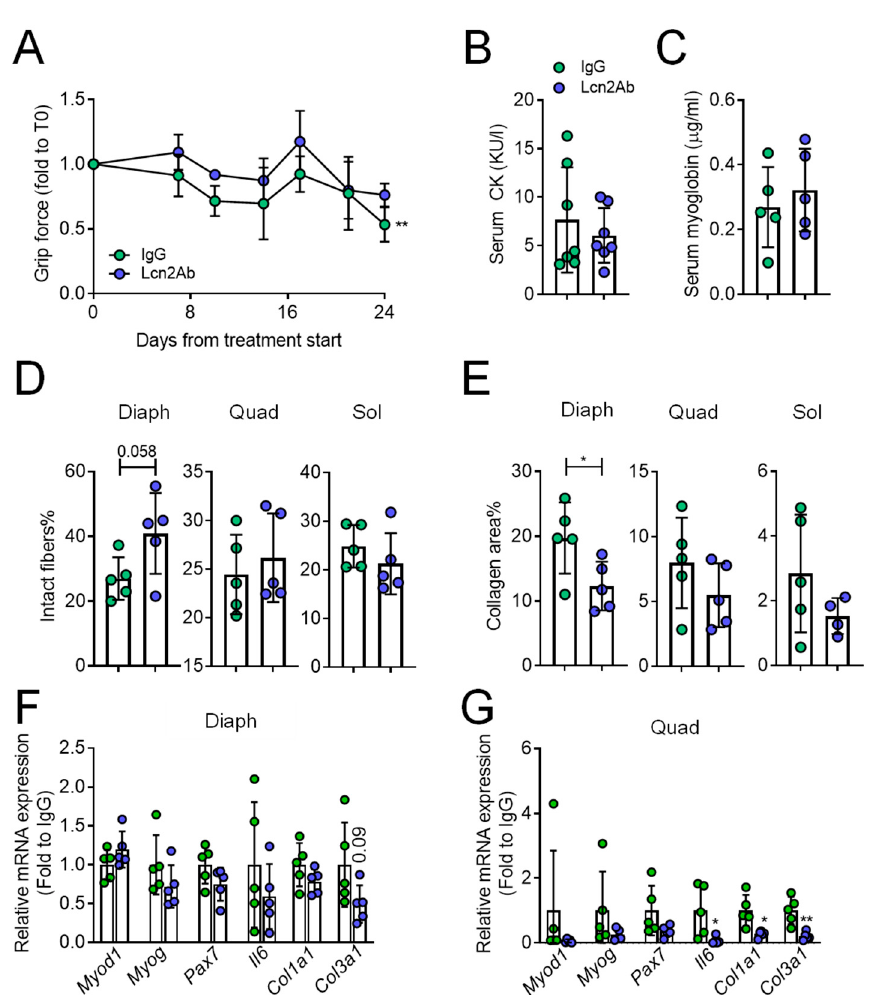
Figure 7. Treatment of MDX mice with anti-Lcn2 antibody: muscle phenotype. ( A ) Evaluation of muscle performance of MDX mice treated with irrelevant IgG (IgG) or with an anti-Lcn2 antibody (Lcn2Ab) during the timeframe of the experiment. ( B ) Reflotron and ELISA assays to evaluate serum levels of creatine kinase (CK) and ( C ) myoglobin, respectively. ( D ) Explanted diaphragm (Diaph), quadriceps (Quad), and soleus (Sol) were snap-frozen without fixation and embedded in OCT. After sectioning, muscles were subjected to haematoxylin/eosin staining to assess % of intact fibres and ( E ) to Masson’s trichrome staining to evaluate fibrosis. ( F ) Diaphragm and ( G ) quadriceps were explanted and subjected to RNA extraction, cDNA synthesis and comparative transcriptional analysis via real-time PCR. The genes analysed were myogenic differentiation d1 ( Myod1 ), myogenin ( Myog ), paired box protein 7 ( Pax7 ), interleukin ( Il)6 , collagen ( Col)1a1, and Col3a1 . Results are the mean ± SD of at least four mice/group. In ( A ), curve fitting test. In ( B – G ) Student’s t -test. * p < 0.05; ** p < 0.01 vs. IgG.